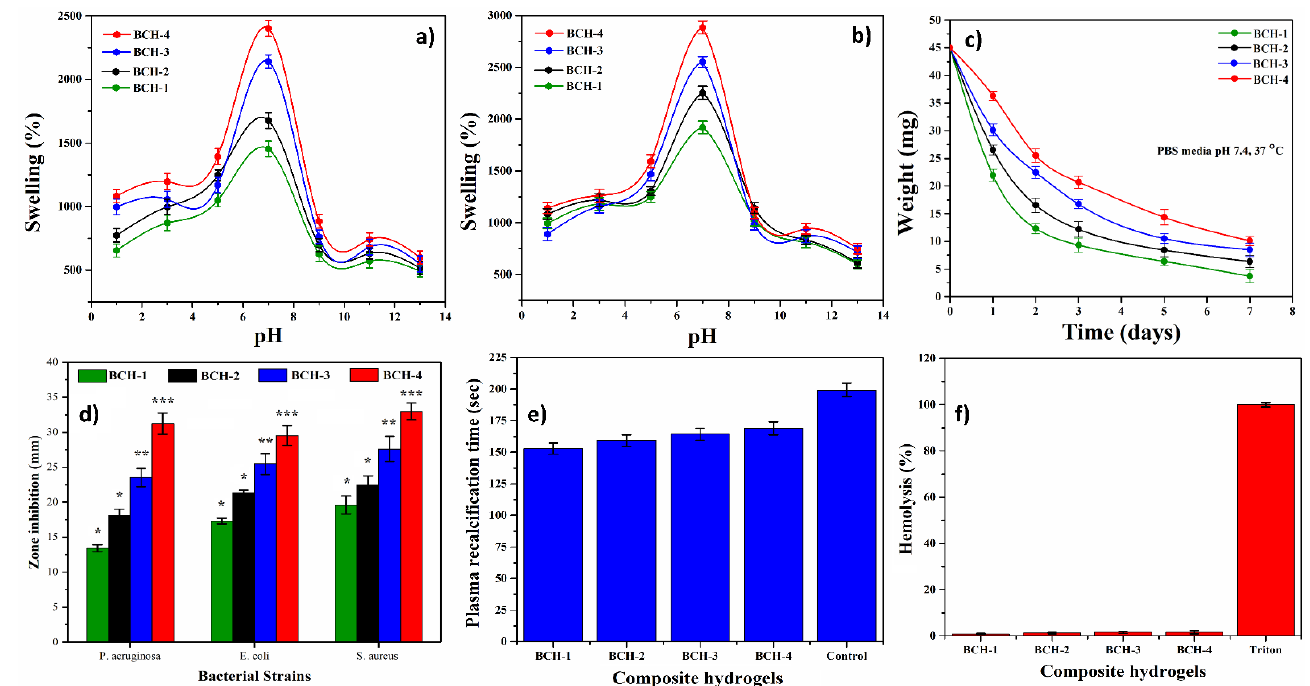
Figure 6. Swelling analysis of hydrogels: ( a ) buffer, ( b ) nonbuffer, ( c ) degradation of hydrogels under in vitro conditions, ( d ) antibacterial activities against different bacterial strains, ( e ) plasma recalcification, and ( f ) hemolysis percentage. (* p < 0.05, ** p < 0.01 and *** p < 0.001).